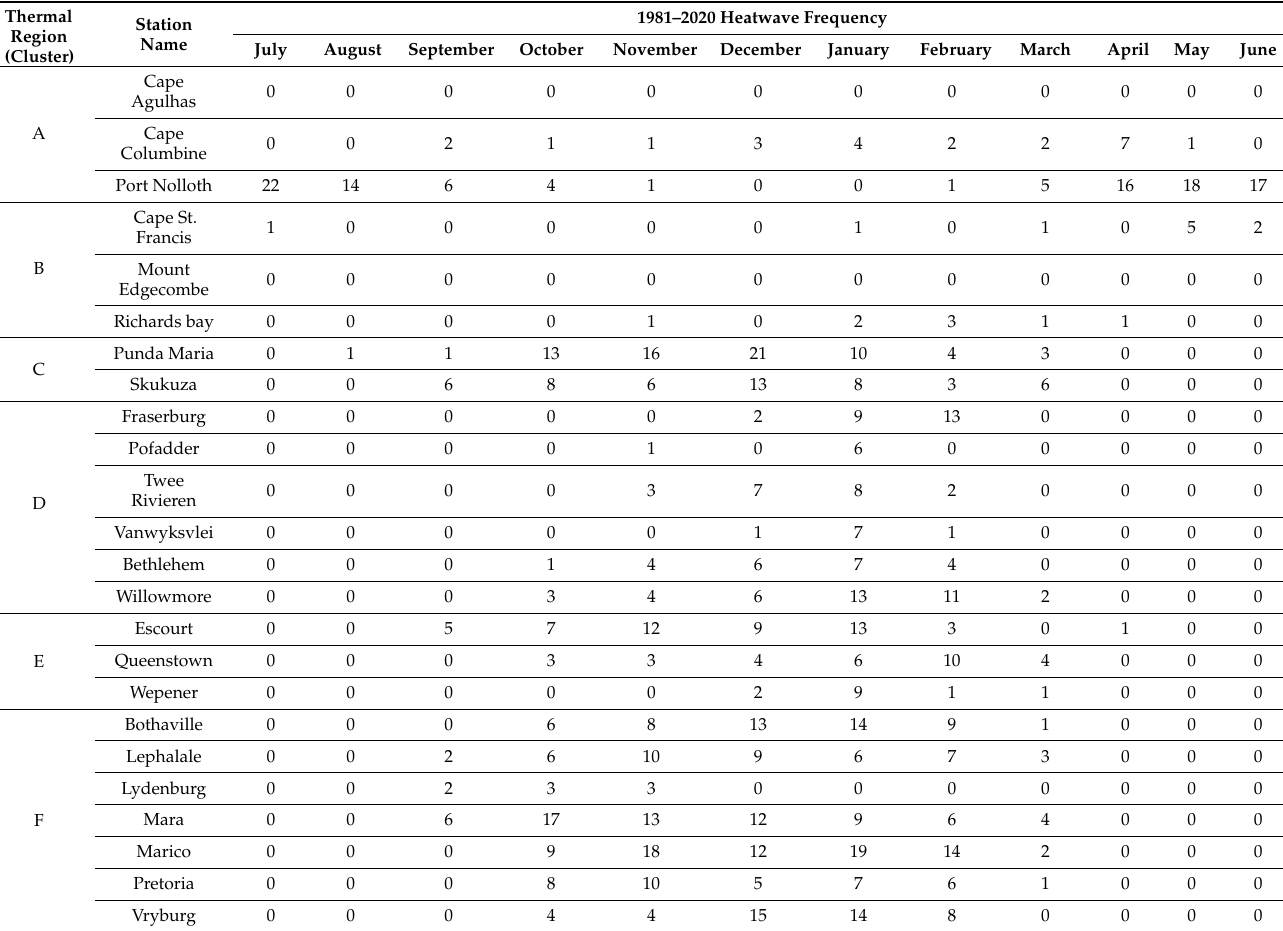
Table 3. The monthly HW frequency from 1981–2020 from the 24 selected